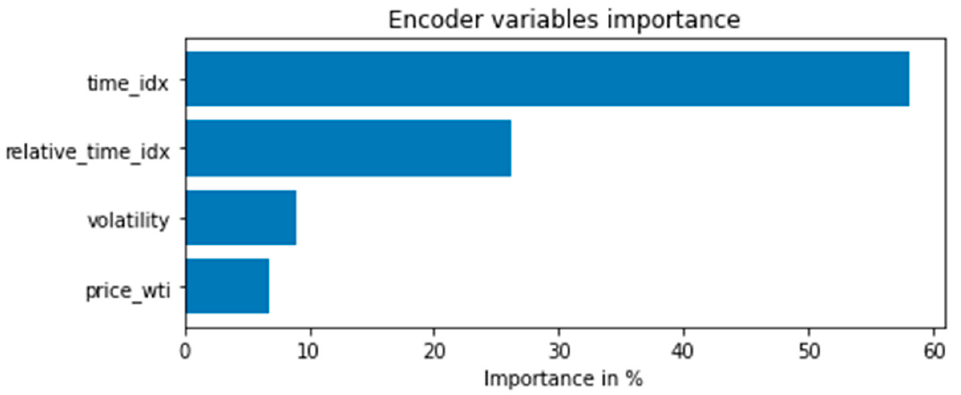
11 of 14 Figure 5. Out-of-Sample Forecast: Scenario 2, Volatility: Nickel/ Con fi dence Intervals 95% (where Linf and Lsup are lower and upper con fi dence limits). Regarding the volatility of Cobalt price returns under Scenario 2, it can be seen that the Out-of-Sample forecasts appear to be an average between the behavior exhibited be- fore and after the 7 November 2022 date, and likewise the 95% con fi dence intervals. On the other hand, with respect to the volatility of Nickel price returns under Scenario 2, the forecasts appear to capture the most recent behavior of volatility, i.e., the period from 7 March 2022 to 12 December 2022, similar to the 95% con fi dence intervals. 4.4. The Importance of the Variables Multi-horizon forecasting in practical applications typically involves utilizing a range of data sources, such as advance knowledge about future events (also known as the known inputs), external time series, and unchanging metadata, with no prior understand- ing of how they relate to each other. The TFT model takes in three types of inputs: unchanging metadata, also known as static covariates, past inputs that change over time, and future inputs that are already known. To select the most important features from these inputs, variable selection is em- ployed to make careful and deliberate choices.